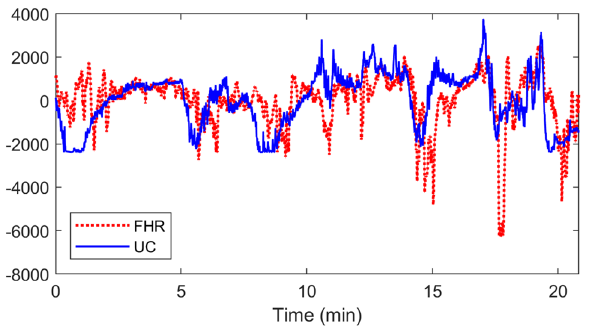
Figure 7. Time plot of cardiotocographic (CTG) recording of Fetal Heart Rate (FHR) and Maternal Uterine Contraction (UC).